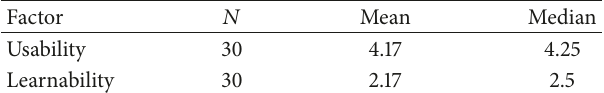
Table 5: Usability and learnability factor.